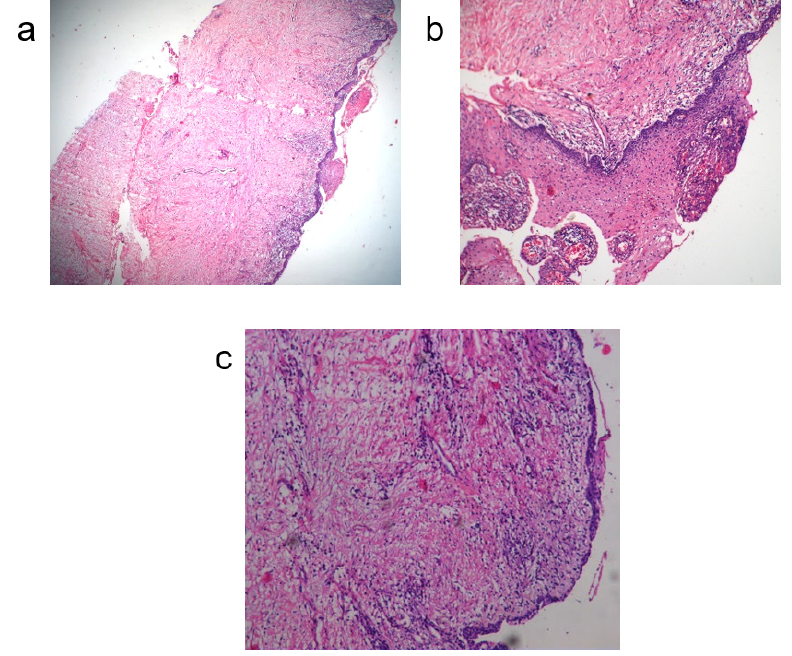
Figure 4. ( a , b ) Photomicrograph of infected dentigerous cyst (×4, ×10). ( c ) Photomicrograph of infected dentigerous cyst showing thin non-keratinized epithelium (×4).